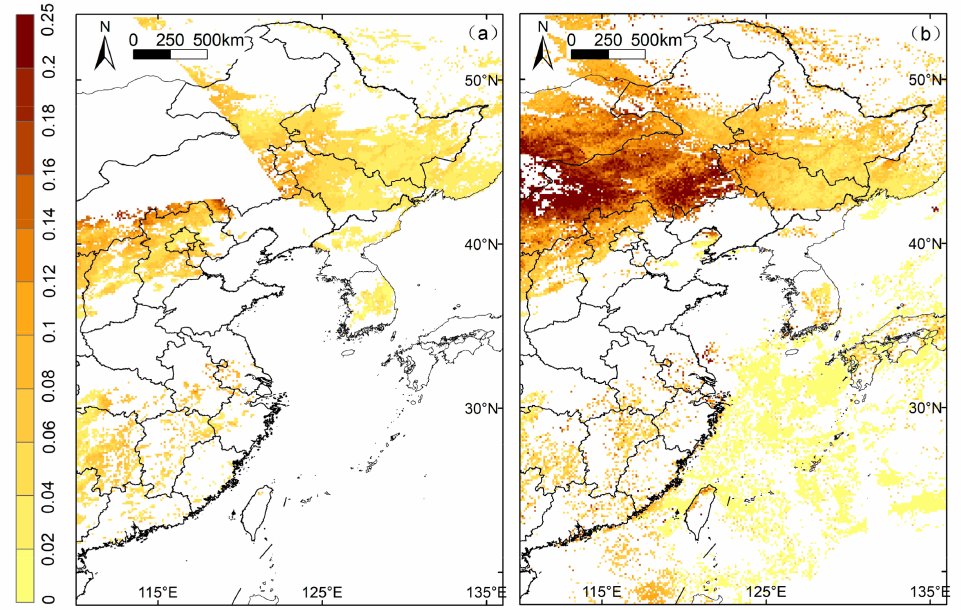
Figure 14. The AVHRR-retrieved surface reflectance ( a ) and MYD09 surface reflectance product maps ( b ) of Eastern Asia on 24 September 2009. AVHRR has filtered oceanic pixels. The upper left space of AVHRR surface reflectance result is due to data missing.